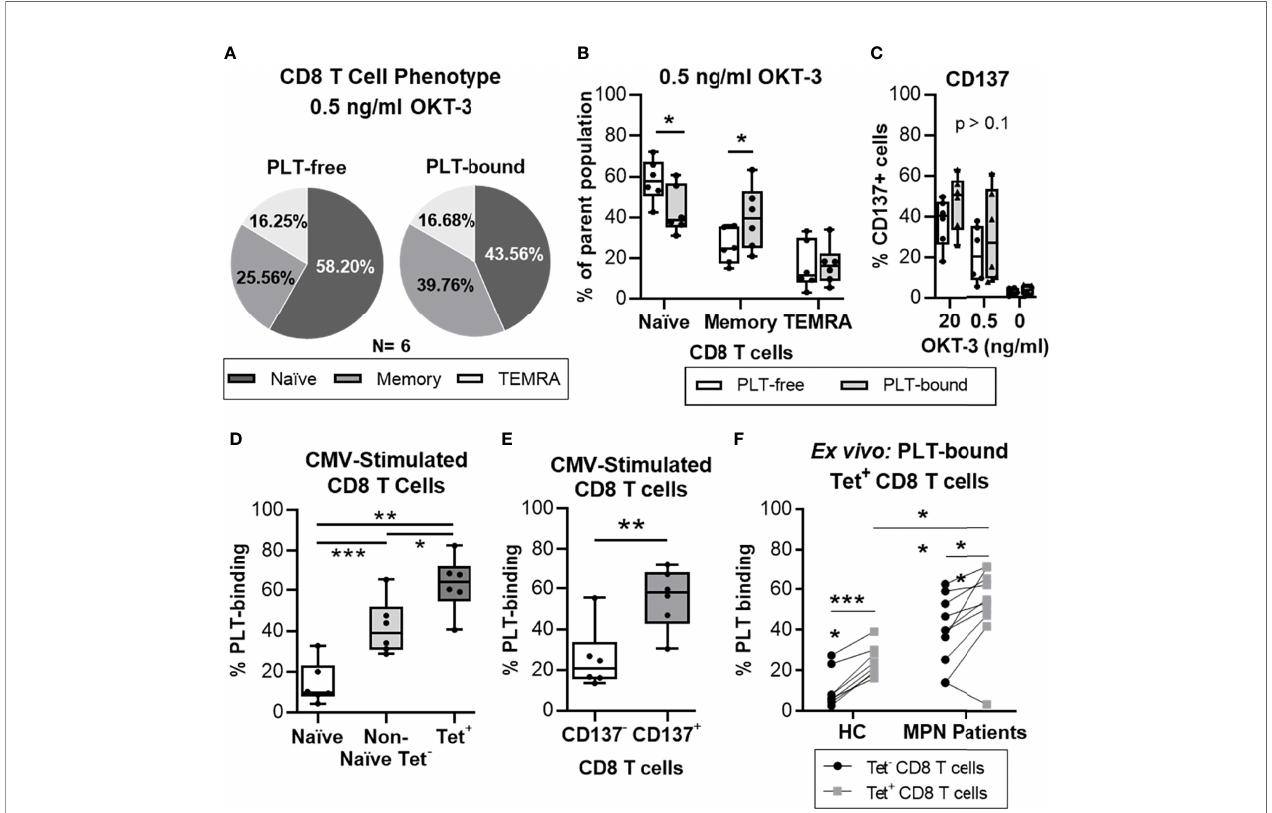
FIGURE 4 | PLTs bind preferentially to antigen-speci fi c CD8 T cells, in vitro and ex vivo . Isolated CD8 T cells from healthy donors were stimulated with OKT-3 (20 or 0.5 ng/ml) for three days. Afterwards, CD8 T cells were co-cultured with PLT for one hour (1:100 ratio), and PLT-binding was assessed by fl ow cytometry (Panel IV, Supplemental Table 1 ). (A) The frequency of Naïve (CCR7 + /CD45RO - ), Memory (CD45RO + ) and terminally differentiated effector (TEMRA; CCR7 - /CD45RO - ) CD8 T cells is shown as the mean value of all donors (N = 6) in a pie chart. The percentages of (B) naïve, memory and TEMRA as well as (C) CD137 + cells are shown for each individual donor for PLT-bound (empty bars) andPLT-free (grey bars) CD8T cells. UnpairedT test was used to compare the PLT-free andPLT-bound populations. Next, PBMCfrom healthy donorswere stimulated twice with a CMV peptide. PBMCwereco-culturedwith PLTas described above and PLT-binding to CMV-speci fi c CD8T cells was evaluated using fl ow cytometry(PanelIV, Supplemental Table 1 ). Frequencies of PLT-binding to (D) Naïve (empty bar), Non-Naïvetetramer - (Non-Naïve Tet - ; CMV-MHC-tetramer - andexclusion of CCR7 + /CD45RO - ; light grey bar) and Tetramer + (Tet + ; darkgray bar), and (E) non-activated (CD137 - ; empty bar)and activated (CD137 + ; grey bar) CD8T cellswere compared using paired non-parametric ANOVA analysisorT test, respectively(n = 6). (F) PBMC from age-matched healthy controls (HC; N = 8) andMPN patients (N= 10) were stained for Flu and CMV MHC-I tetramer,and the circulating frequencies ofPLT-bound to MHC-tetramer negative (Tet - ; (cid:129) ) and virus-speci fi c (Tet + ; ▪ ) CD8 T cells were analyzed by fl ow cytometry(Panel V).Paired T tests were usedto compare unspeci fi c andvirus-speci fi c frequencies, whereas unpairedT test was used to compare the virus-speci fi c populationsin HC and MPN patients. Allfrequencies are shownas percentage of parent population andthe boxplots represent the median ± interquartile range of the populations, whilethe whiskersextend to the maximum andminimum values. Differences were considered signi fi cant when p<0.05, as indicatedwith asterisks(*p < 0.05, **p < 0.01, ***p < 0.001, and ****p <